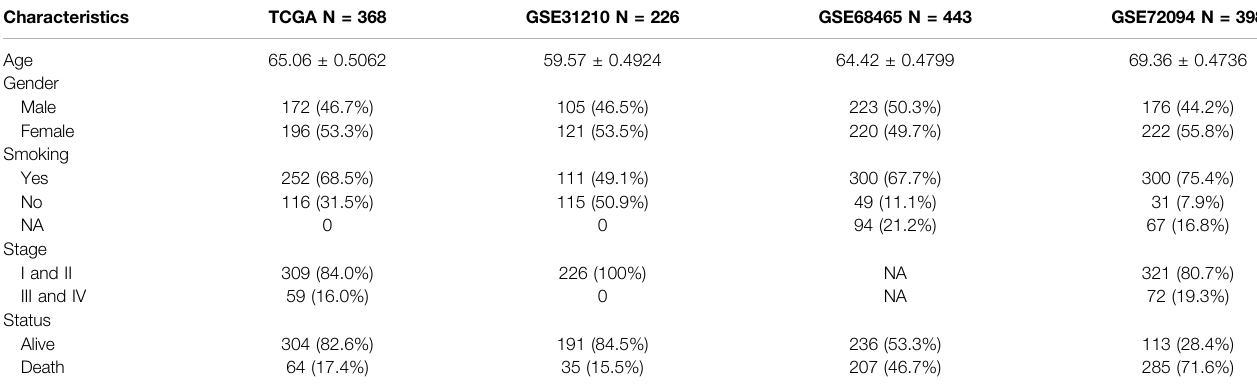
TABLE 1 | Clinical characteristics of the patients from multiple institutions.